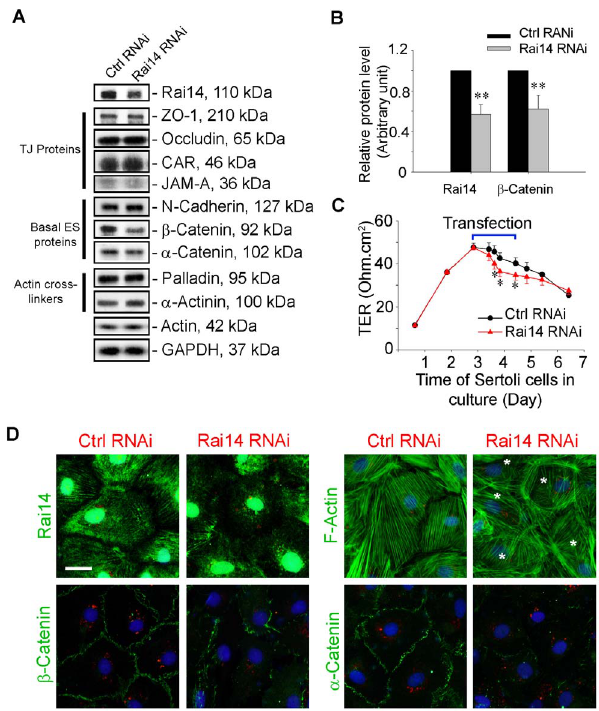
Figure 5. Knockdown of Rai14 in the Sertoli cell epithelium with an established TJ-permeability barrier in vitro by RNAi disrupts actin filament organization and the TJ barrier. (A) Sertoli cells cultured alone on Matrigel-coated 12-well dishes for 2-day